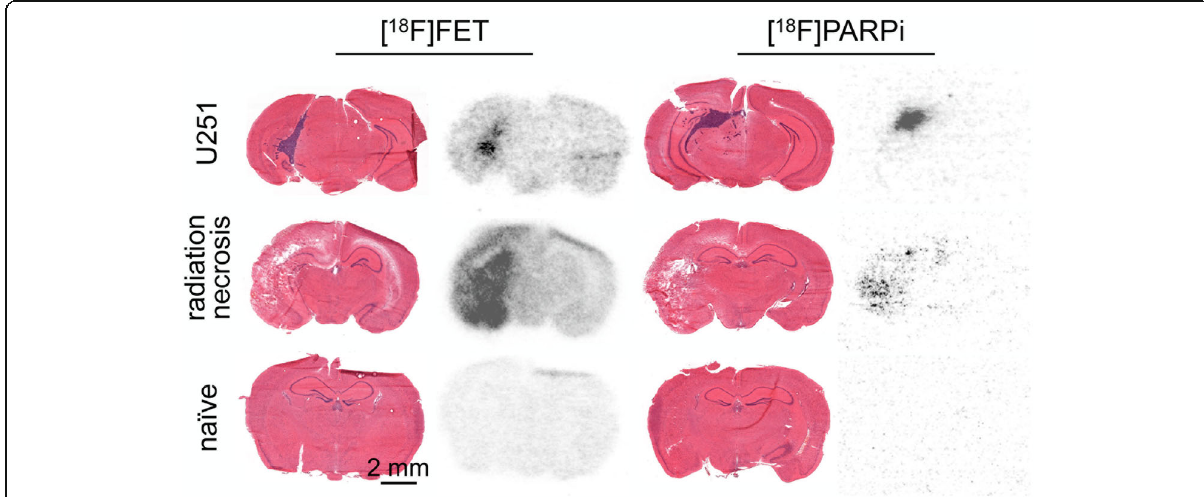
Fig. 3 Hematoxylin and eosin stains and autoradiography. Hematoxylin and eosin stains (left) and digital storage phosphor autoradiography (right) of whole transaxial sections of mice with implanted U251 tumors (top row), experimental radiation necrosis (middle row), and naïve mice (bottom row), injected with [ 18 F]FET (left column) or [ 18 F]PARPi (right column). Autoradiographic scans have been contrast-adjusted for visibility. Mice were sacrificed 2.5 h post-injection of radiotracer